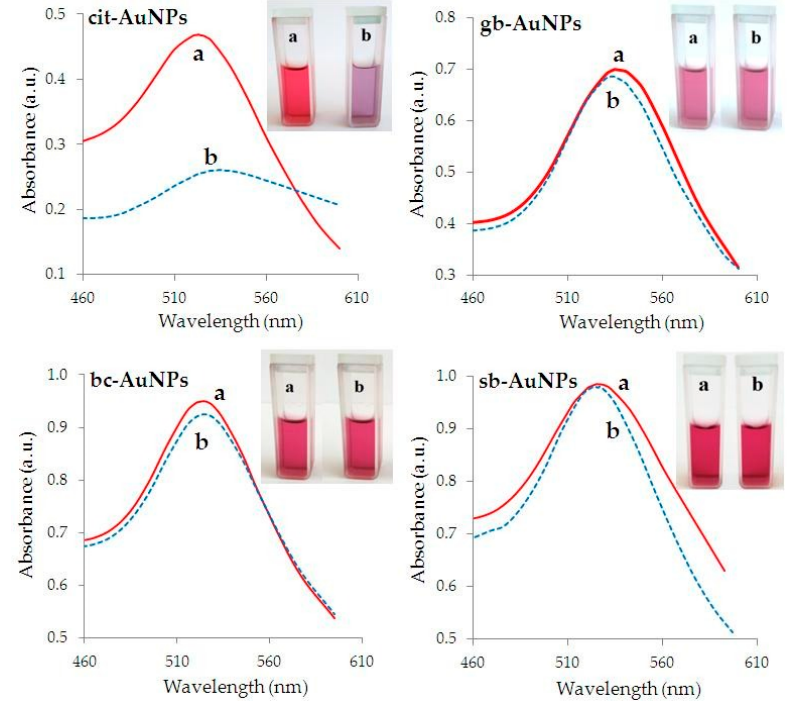
Figure 9. UV-Vis spectra and corresponding photographs of cit-AuNPs, sb-AuNPs, bc-AuNPs and gb-AuNPs suspensions before ( a ) and after ( b ) ultrasound exposure. Parameters of ultrasonic treatment: Ti-microtip, frequency 20 kHz, amplitude 20%, duration 10 min.